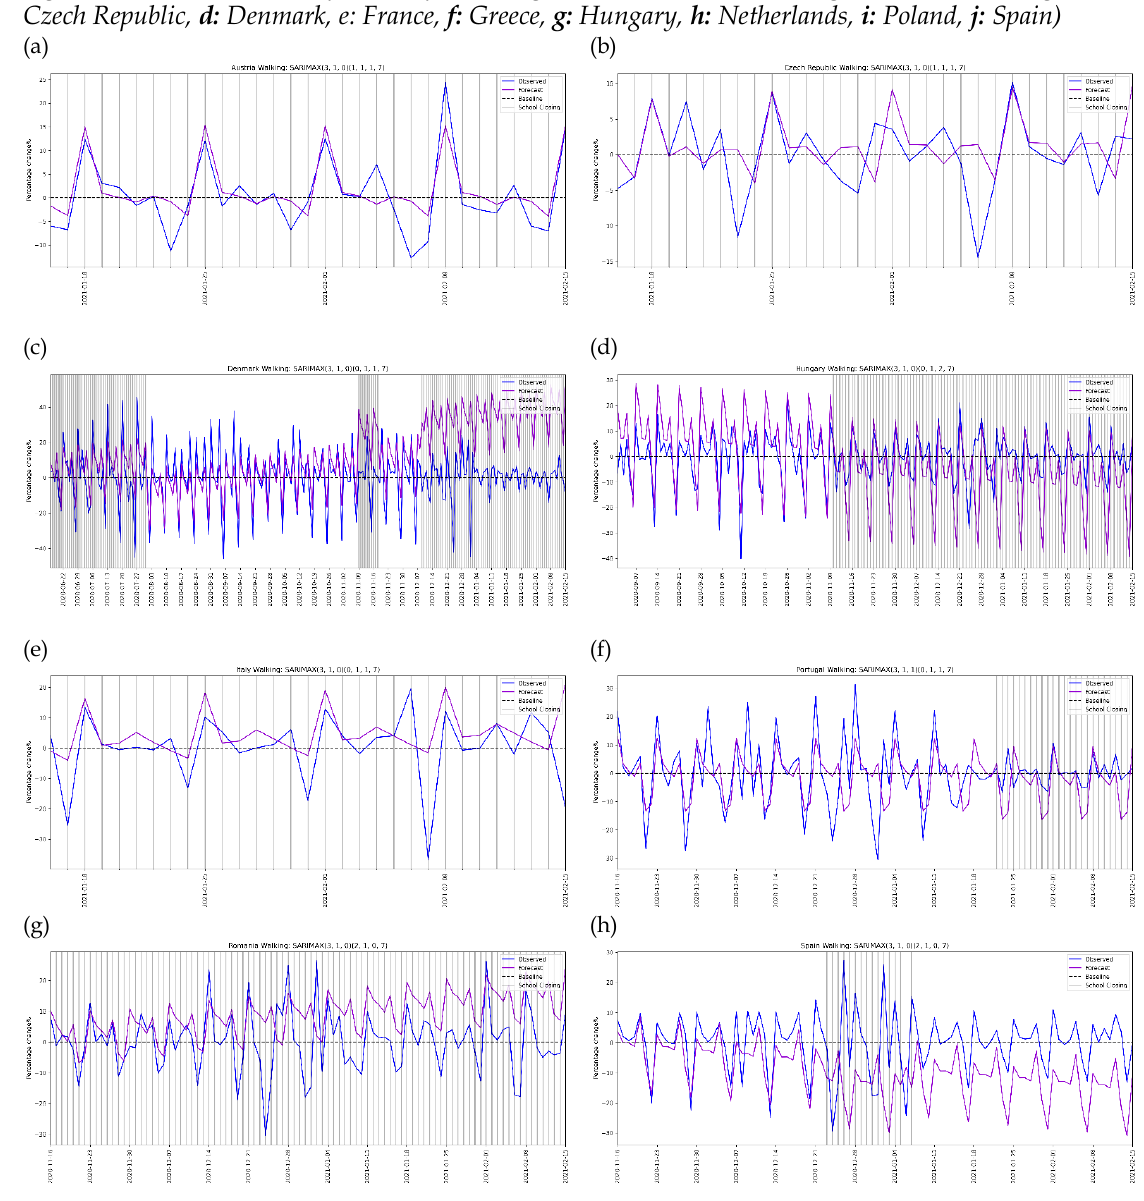
Figure 7. SARIMAX forecasts for driving in relation to school closing ( a: Austria, b: Belgium, c: Czech Republic, d: Denmark, e: France, f: Greece, g: Hungary, h: Netherlands, i: Poland, j: Spain)